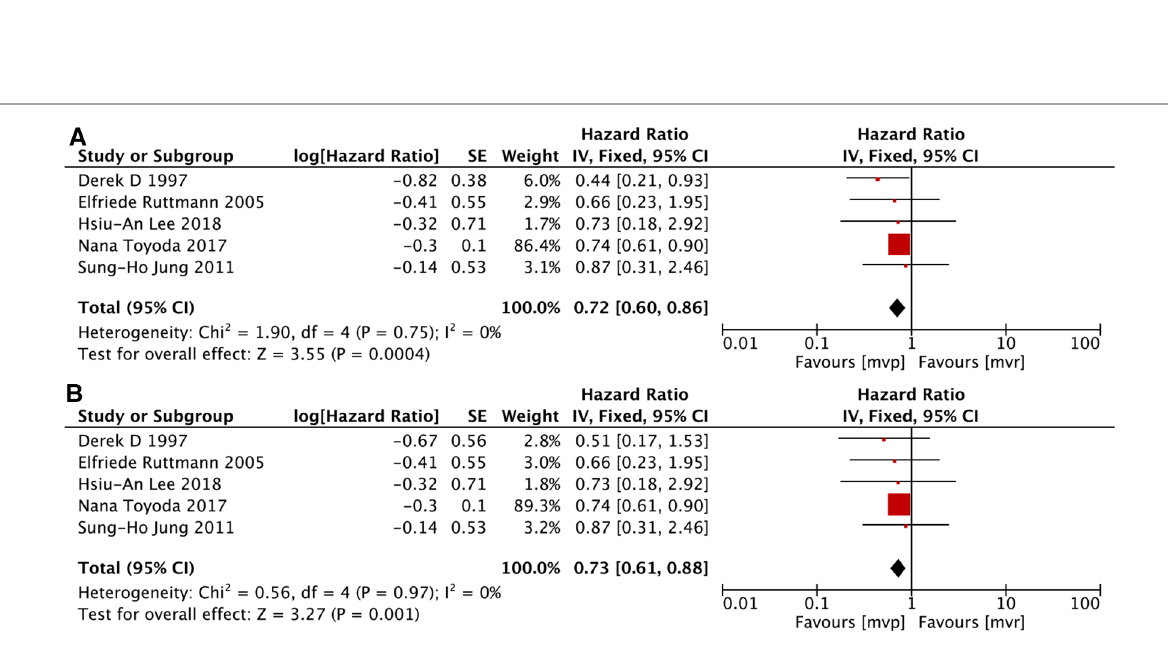
FIGURE 4 Meta-analysis for event-free survival: ( A ) MVP vs. MVR; ( B ) MVP vs. MVR (active IE); MVP, mitral valve plasty; MVR, mitral valve